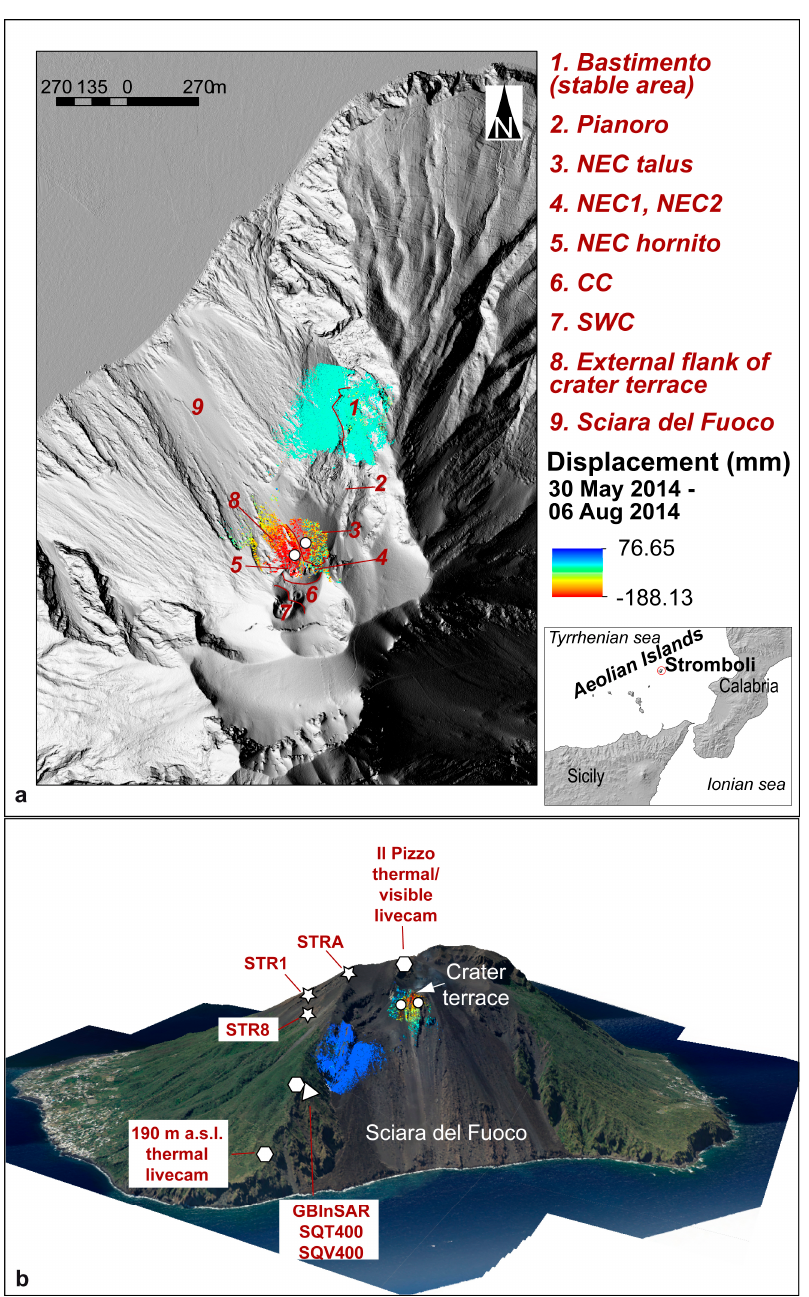
Figure 1. ( a ) Geographic setting of the Island of Stromboli, located at the easternmost end of the Aeolian Archipelago, and names of the summit vents within the crater terrace. NEC: North-East Crater area; CC: Central Crater area; SWC: South-West Crater area ( b ) 3D-view of the investigated sectors observed from north, highlighting the location of the measurement stations used in this work. STR1, STR8, and STRA: broadband seismic stations. SQT400 and SQV400: thermal and visible live cam, respectively. In both ( a ) and ( b ), the line of sight (LOS) displacement map produced by the GBInSAR apparatus between 30 May 2014 and 6 August 2014 is also shown, highlighting the strong inflation of the crater terrace and the stability of the Sciara del Fuoco before the 2014 flank eruption. The measure-areas of the time-series are indicated by white circles. All Digital data were collected in the Projected coordinate system: WGS 1984 UTM zone 33 Projection: Transverse Mercatore. Maps were generated using ESRI ArcGIS CAMPUS (Università degli Studi di Firenze Licence; http://www.siaf.unifi.it/vp-1275-arcgis-licenza-campus.html).